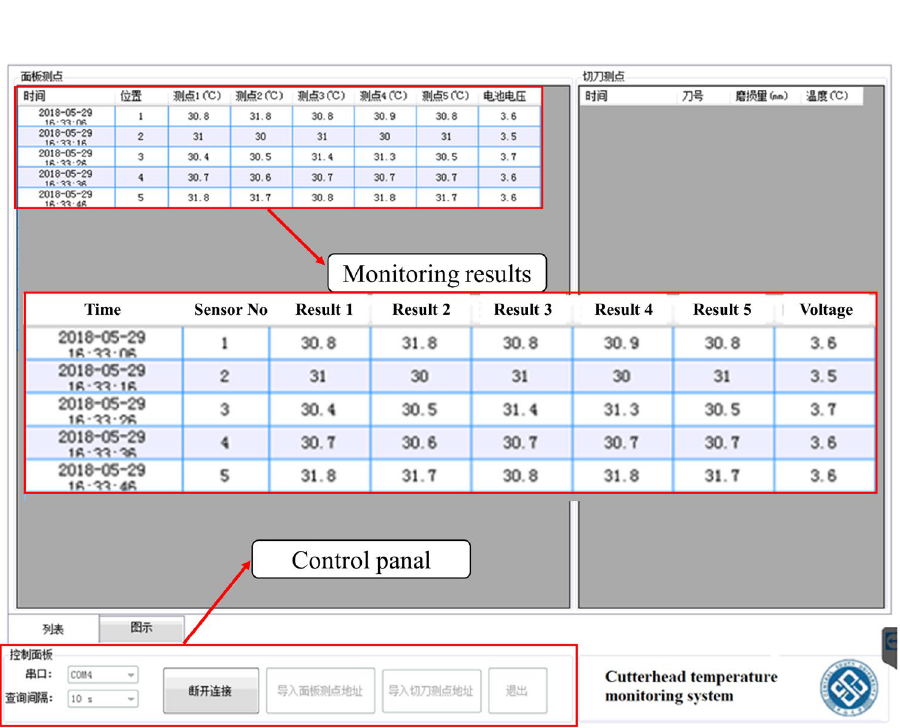
Figure 11. Self-developed temperature monitoring